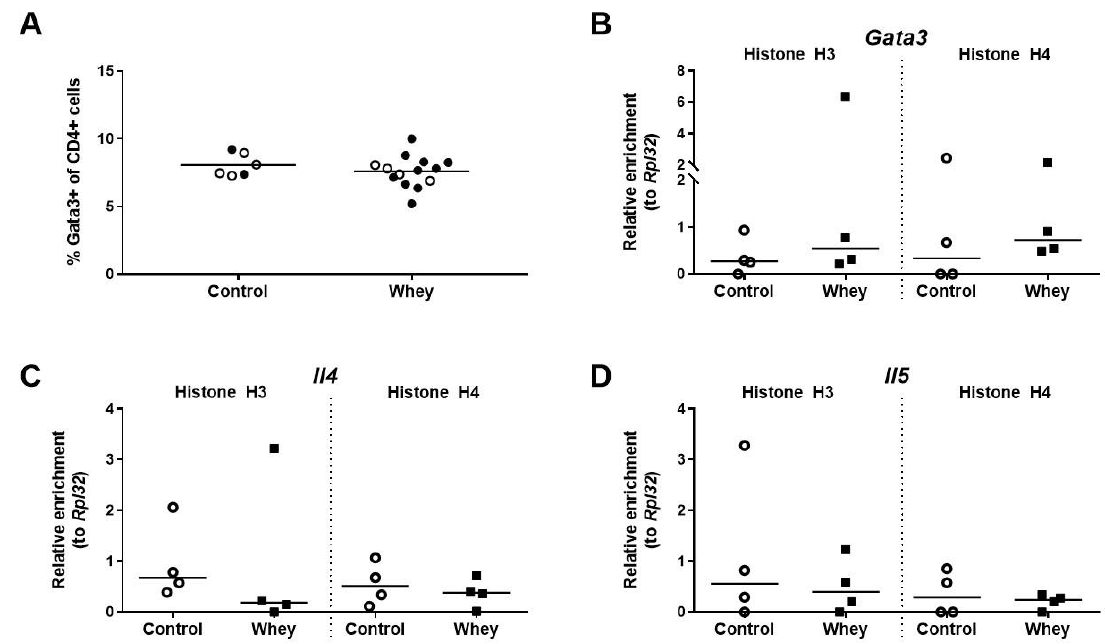
Figure 3. A confirmed allergic response to whey protein a ff ected neither the percentages of Th2 cells in the spleen nor the H3 and H4 histone acetylation levels of Th2-related genes in the total CD4 + T cell population in the spleen. ( A ) The percentage of CD4 + T cells positive for GATA binding protein 3 (Gata3) in the spleen as assessed by flow cytometry. Data are presented as a scatter dot plot showing individual data points and mean. Open circles indicate the mice that were included in the histone modification analysis. Data of one mouse in the control group was excluded due to a technical error. Comparisons were performed with an unpaired t test. The histone acetylation levels at the Gata3 gene ( Gata3 ) ( B ), the interleukin 4 gene ( Il4 ) ( C ), and the interleukin 5 gene ( Il5 ) ( D ) in the total CD4 + T cell population in the spleen as determined by chromatin immunoprecipitation followed by qPCR. Data are presented as scatter dot plots showing individual data points and median. Comparisons were performed with a Mann–Whitney U